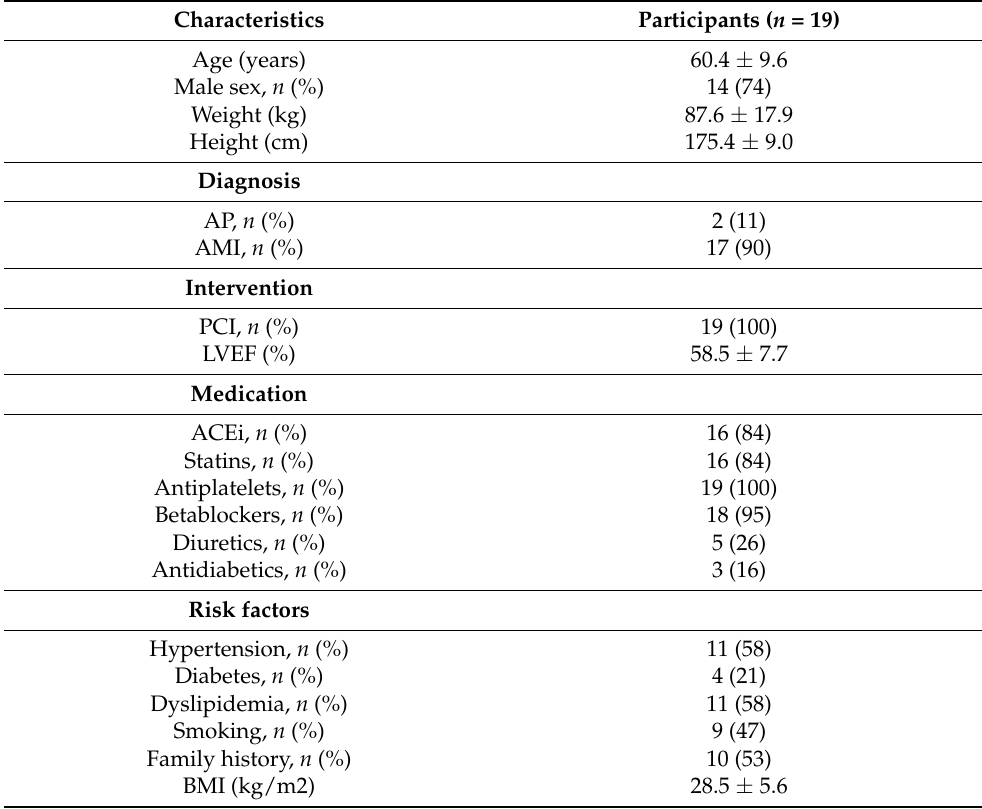
Table 1. Baseline characteristics of the study